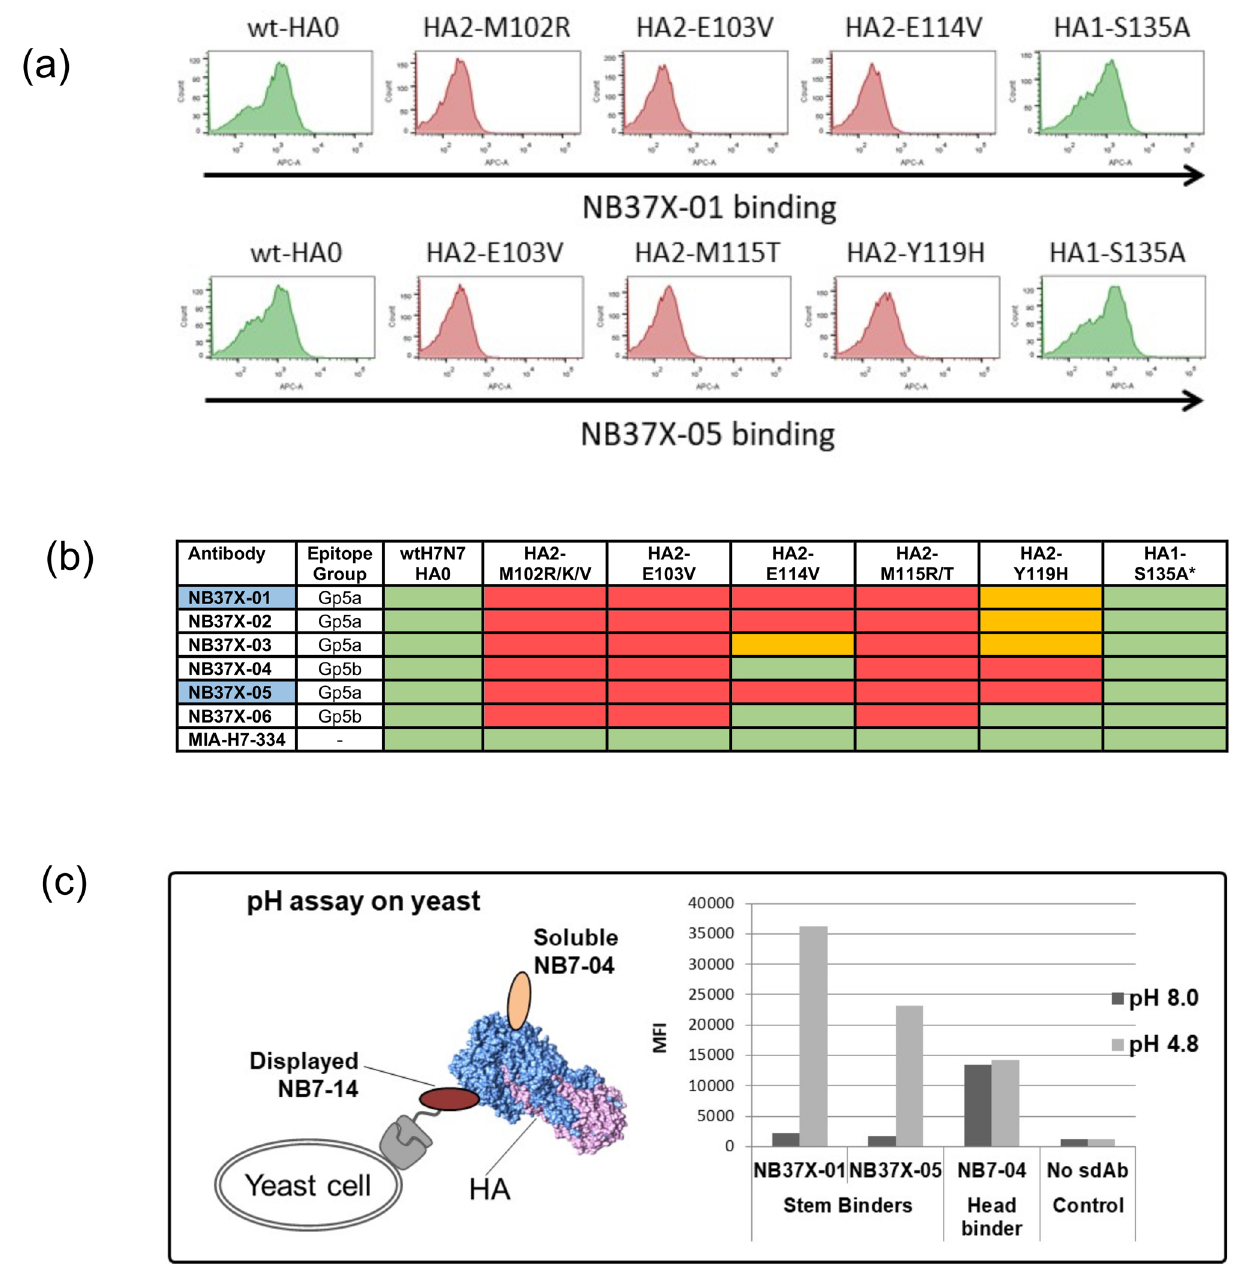
Figure 4. Epitope footprint of H3/H7 cross-reactive nanobodies. ( a ) Flow cytometry histograms (FlowJo 10.4 software) showing NB37X-01 and NB37X-05 binding to displayed wild type H7-HA0 and mutants selected ( b ) Nb binding activity to a panel of yeast displayed HA0 mutants. Residue numbering is relative to HA2 domain. The Nbs used for epitope mapping are highlighted in blue. Commercial antibody MIA-H7-334 is included as positive control and retains binding to all mutants. Relative binding of Nbs to each displayed mutant were categorized as follows: ≤ 15% no binding (red), between 15 and 40% intermediate binding (orange) and ≥ 40% strong binding (green). *Represents retention of binding to the HA1 head domain carrying a non-relevant mutation HA1-S135A ( c ) yeast cells displaying the head specific Nb NB7-14 were incubated with HA treated with low and neutral pH and binding of the stem specific Nbs NB37X-01 and NB37X-05 was detected as mean fluorescent intensity (MFI). NB7-04 was a non-competing head specific nanobody